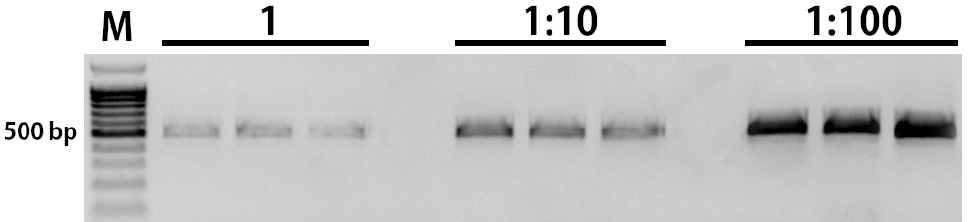
Figure 3. Inhibition of PCR upon addition of aqueous dilutions of pollenkitt to A. cepa genomic DNA as an amplification template and the LFS gene as a target. The PCR experiment was repeated three times with each dilution. Dilution 1 represents the equivalent amount of pollenkitt eluated from 10 µ g of